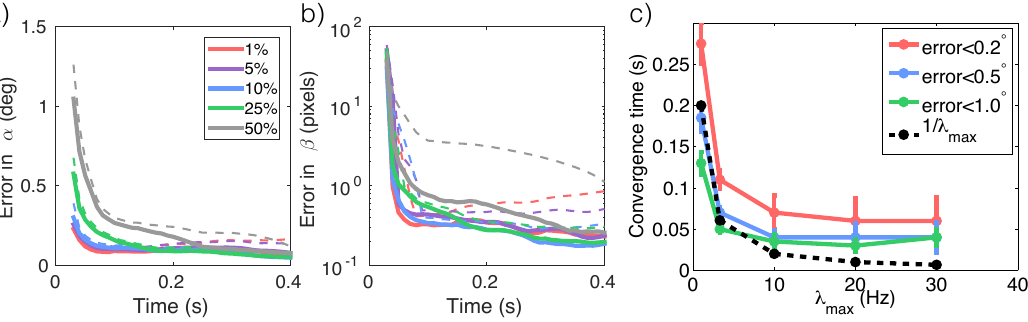
Figure 8. Tracking performance. The average estimation error in ( a ) the pendulum angle α t and ( b ) in cart position β t over time as a function of the amount of dark current (cid:101) dc (color-coded). The photon emission rate is set at λ max = 10 Hz. Dashed lines shows 1std above the mean. ( c ) The tracker’s convergence times for its angle estimates to be within 0.2 ◦ ,0.5 ◦ and 1 ◦ , respectively, of the truth as a function of illuminance. (cid:101) dc is set at 10%. As a reference “1/ λ max ” is inversely proportional to the illuminance and scaled to have roughly the same starting position as the “error < 0.5 ◦ ”